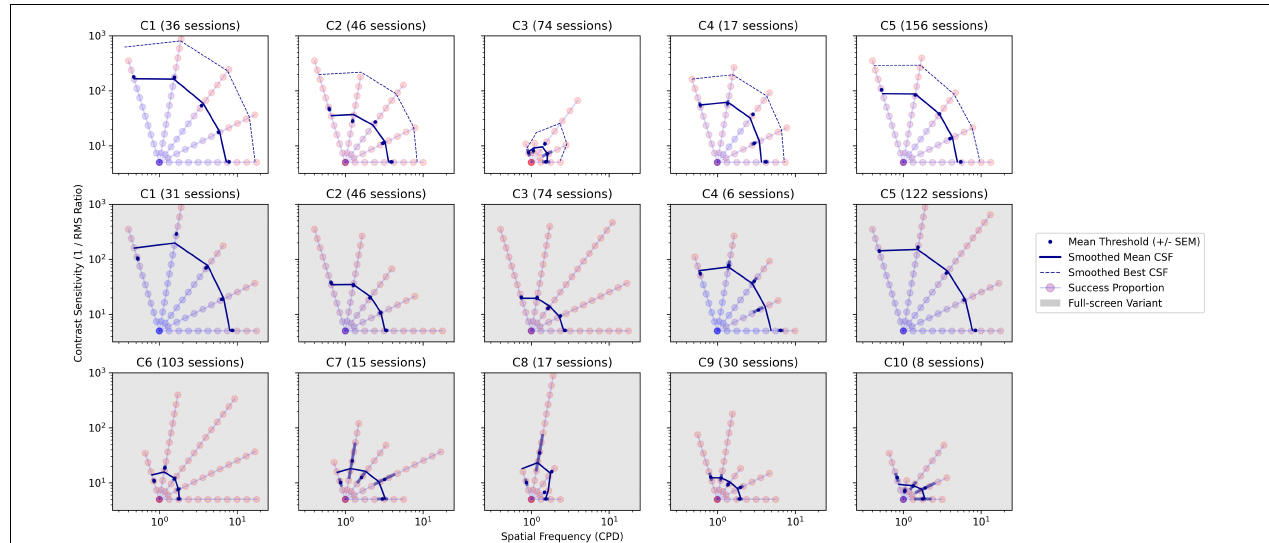
FIGURE 9 | Gradiate CSFs from the standard variant for observers C1 to C5 (top row) and from the full-screen variant for all observers (middle and bottom rows, gray background). The horizontal and vertical axes (both log) represent spatial frequency in cycles per degree and RMS contrast sensitivity, respectively. Each colored circle represents one step in a radial sweep of stimuli progressing outward (and becoming harder to see) from a common origin. The color of each circle varies from red to blue depending on the proportion of presentations of that stimulus in which the observer successfully tracked it (with blue denoting a higher success rate). The solid blue line in each panel is a smoothed CSF interpolated from the mean thresholds of all five sweeps. In the top row, a dotted blue line is also shown representing a smoothed CSF interpolated from the best thresholds of all five sweeps. The total number of sessions for each child/task is shown above each panel.